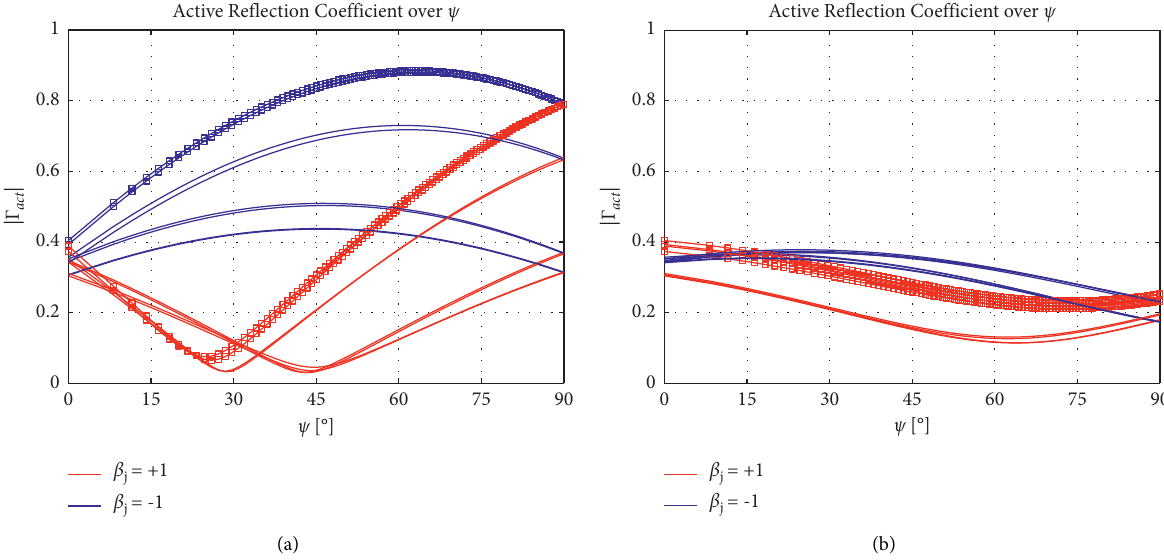
Figure 9: Active reflection coefficient over outspacing angle ψ of the designed 4 × 4 array without beam steering in the nonsymmetrical and symmetrical outspacing configuration. The marked traces refer to the four center elements and the color to the outspacing polarity ( β ) . (a) Nonsymmetric configuration. (b) Symmetric configuration. j